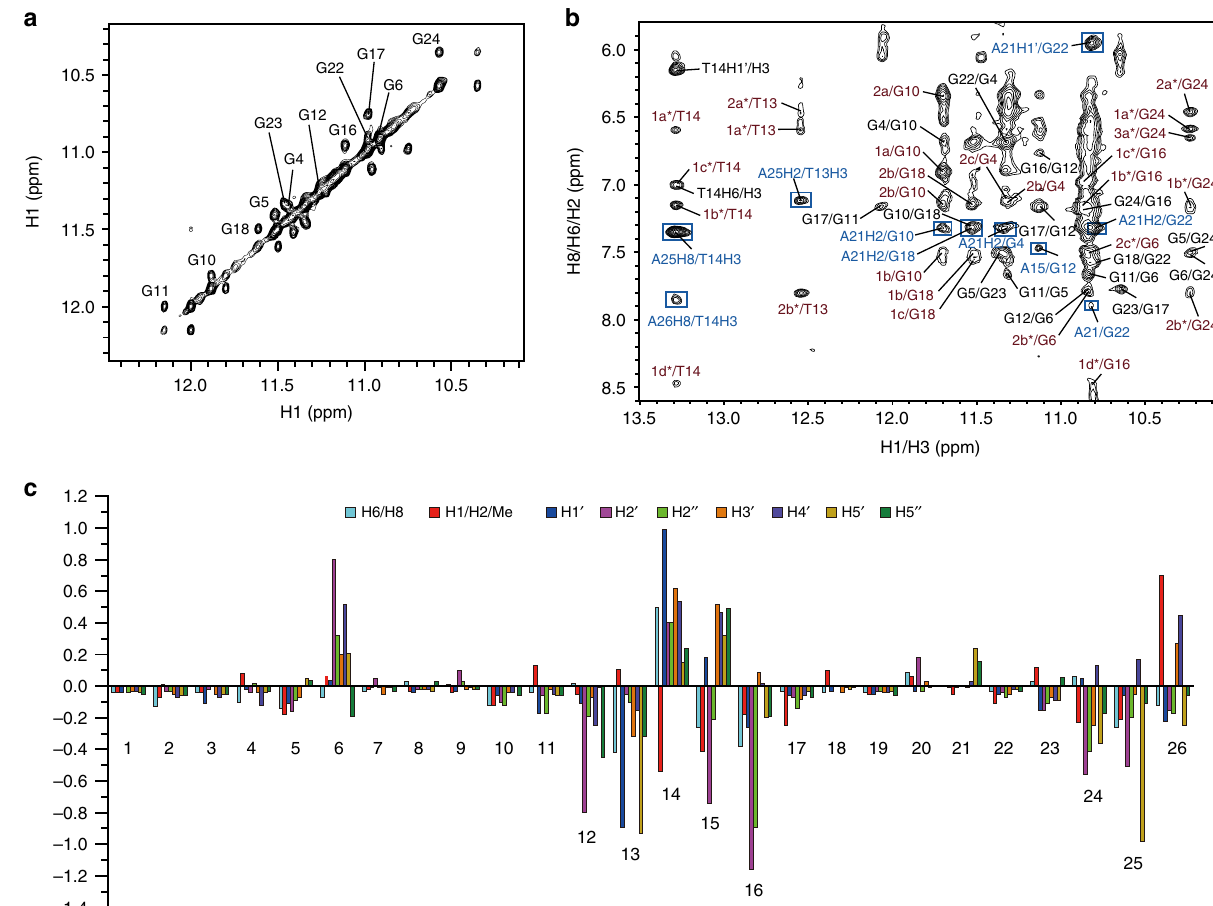
Fig. 5 NMR spectra of the unique dimeric 4:2 Pt-tripod – Tel26 complex. a The expanded H1-H1 region at a Pt-tripod/Tel26 ratio of 2.0 at 25 °C. Exchange cross-peaks of Tel26 between 1:1 and 4:2 complexes are labeled. b The expanded H1/H3-H8/H6/H2 region of the 4:2 complex at 15 °C. The G x H8-G y H1 NOEs of G-tetrads are colored in black. Inter-residue NOEs of loop/ fl anking residues are framed and colored in blue. Intermolecular NOEs between the Pt-tripod and G-tetrad are in red. Assignments belonging to the 5 ʹ -Pt-tripod and 3 ʹ -Pt-tripod are labeled without or with asterisks. c The chemical shift difference of Tel26 protons between the 1:1 and 4:2 Pt-tripod – Tel26 complex at 25 °C. Condition: 100 mM K + , pH